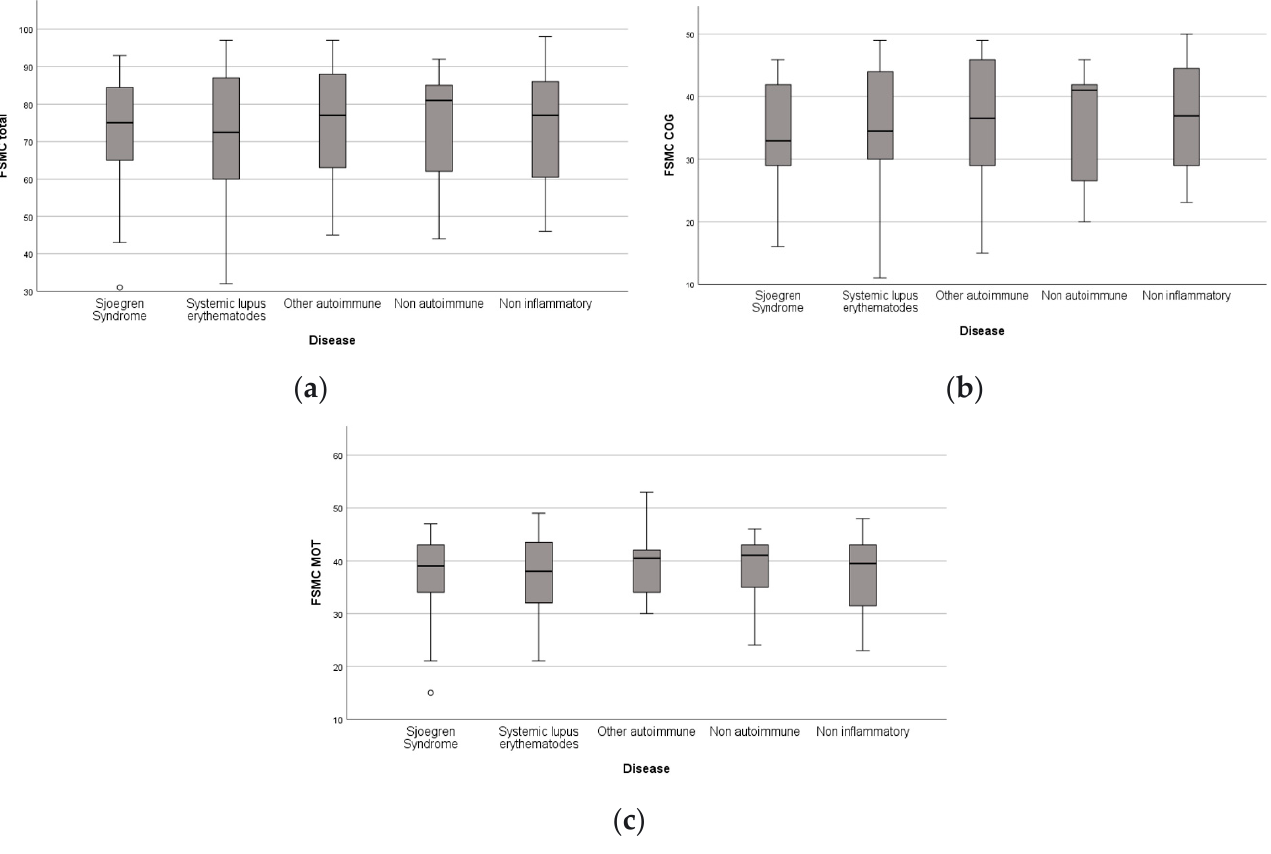
Table 3. ( a ) Correlation by Spearman-Rho of circulating anti-NR2 antibody titer and cognitive fa- tigue severity in the different groups of patients with rheumatic diseases. ( b ) Correlation by Spear- man-Rho of circulating anti-NR2 antibody titer and motor fatigue severity in the different groups of patients with rheumatic diseases. ( c ) Correlation by Spearman-Rho of circulating anti-NR2 anti- body titer and total fatigue severity in the different groups of patients with rheumatic diseases.